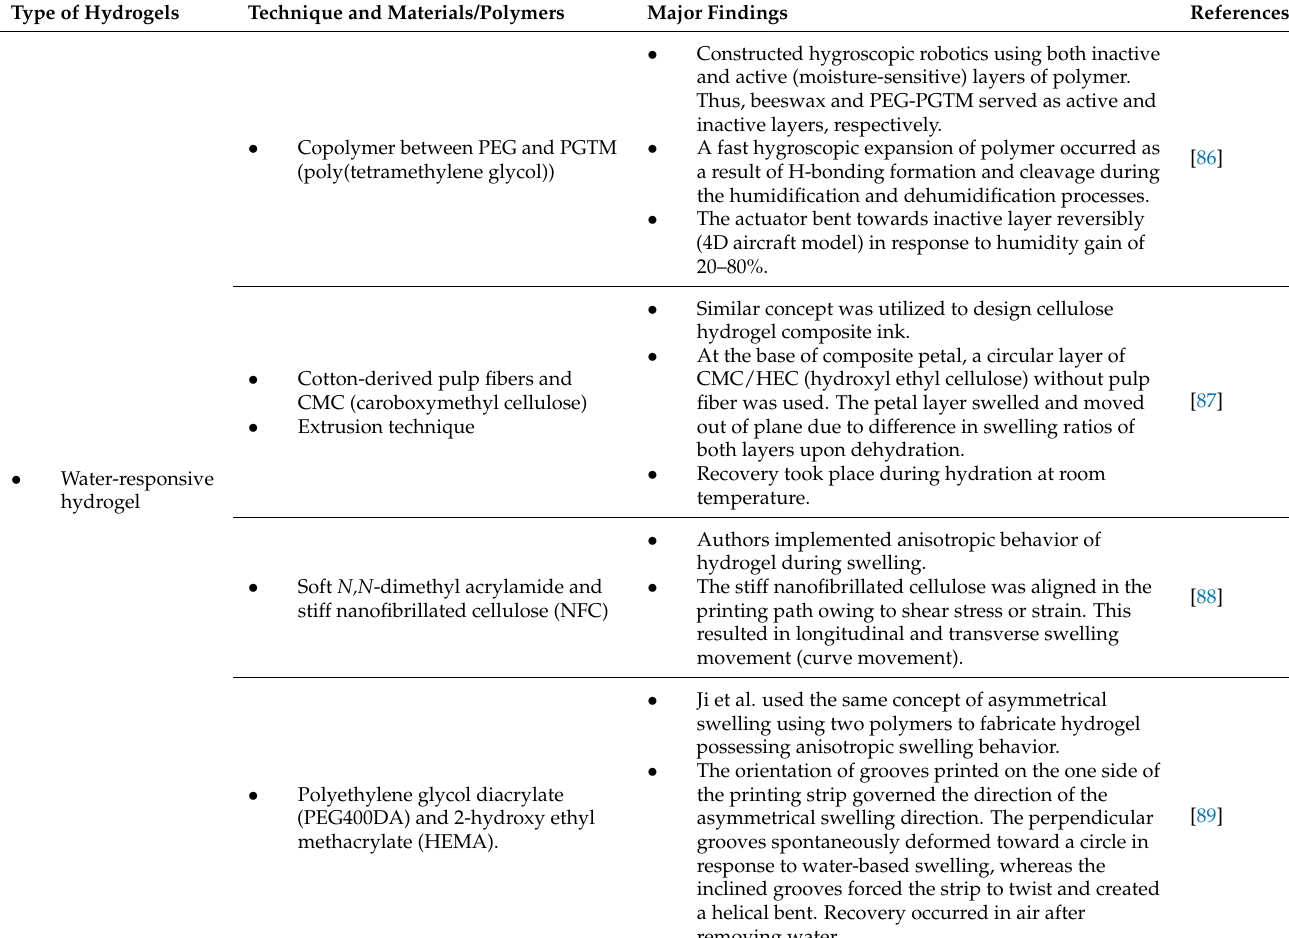
Table 4. Various stimuli responsive, shape-memory hydrogels (SMHs)